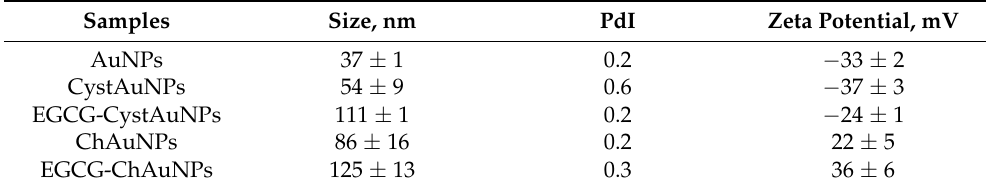
Figure 1. TEM image of: ( A ) ChAuNPs and ( B ) CystAuNPs. The scale bar is 100 nm. Table 1. Hydrodynamic diameter, polydispersity index (PdI) and zeta potential of AuNPs, Cys- tAuNPs, EGCG-CystAuNPs, ChAuNPs,